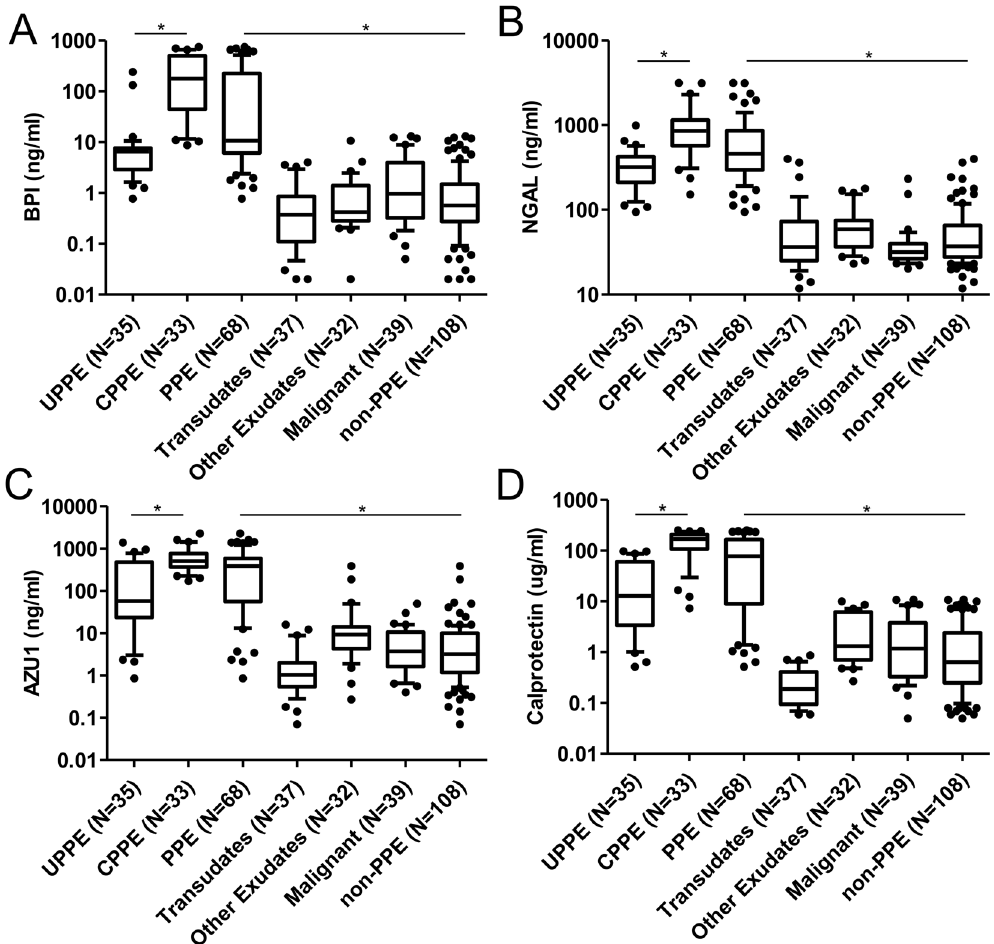
Figure 2. Box plots of the concentrations of four biomarkers in five types of pleural effusions. The pleural effusion levels of ( A ) bactericidal permeability-increasing protein (BPI), ( B ) neutrophil gelatinase-associated lipocalin (NGAL), ( C ) azurocidin (AZU1), and ( D ) calprotectin from patients with UPPE, CPPE, transudates, other exudates, and malignant were determined by sandwich ELISA. PPE refer to UPPE and CPPE. non-PPE refer to transudates, other exudates, and malignant. Horizontal lines represent mean values. * P < 0.0001, indicates statistical significance using nonparametric Mann-Whitney U test. PPE: parapneumonic effusion; UPPE: uncomplicated parapneumonic effusion; CPPE: complicated parapneumonic